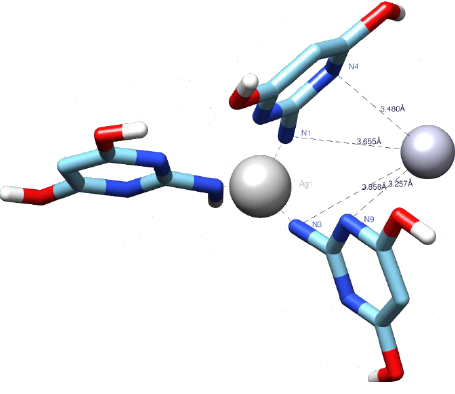
the bond length of 3.655 Å , 3.858Å , 3.480 Å and 3.257 Å respectively, forming a APD-AgNPs-Hg